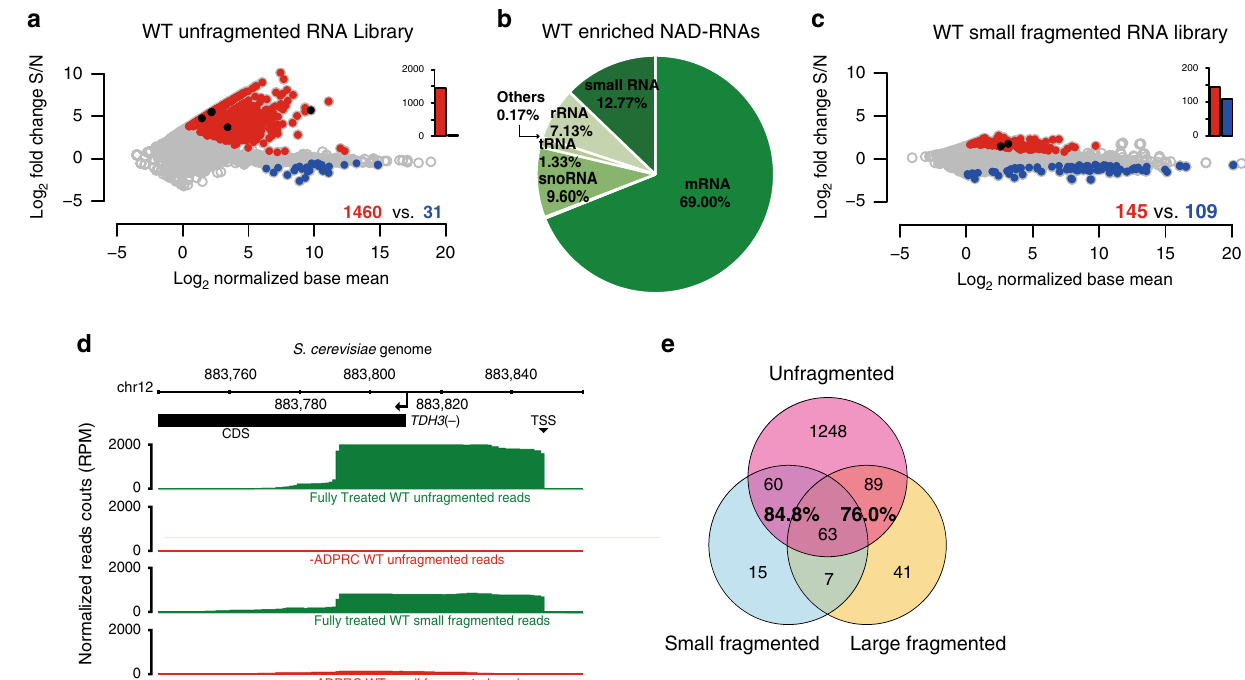
Fig. 1 NAD-RNAs are abundant in the yeast S. cerevisiae . a Enriched NAD-RNAs as determined by unfragmented NAD captureSeq on the wild-type (WT) strain. The log 2 fold change between fully treated sample (S) and minus ADPRC negative control (N) is plotted vs. the log 2 normalized base mean. Different transcripts (7620) were analyzed and are represented as a dot. Red dots represent enriched NAD transcripts (fold change (FC) > 1.414, normalized base mean (NBM) > 1, p < 0.05); blue dots represent negatively enriched transcripts (FC < 0.707, NBM > 1, p < 0.05); black dots denote transcripts previously reported as NAD-capped 8 . The bar chart represents the number of red and blue dots using the same color. Performed in biologically independent replicates, n = 3. b Reads of enriched NAD-RNA from the WT unfragmented NAD captureSeq library, mapped to genome-annotated RNAs. Chart contains reads classi fi ed as genome-annotated RNAs (reads ≥ 18 nt, same statistics parameters as in a ), plus the self-categorized small RNAs (12 nt ≤ reads < 18 nt, fold change S/N > 1.414). Other categories included the classes pseudogene (0.093%), ncRNA (0.057%), and long-terminal repeat RNA (0.017%). The pie chart represents the number of reads assigned to each RNA class as percentage of total reads. c Enriched NAD-RNAs as determined by small fragmented NAD captureSeq on WT strain. Random-sheared total RNA as input and sized selected cDNA (insert < 172 bp) was utilized for library building. Statistics parameters are as in a . Performed in biologically independent replicates, n = 3. d Aligned sequencing reads of the TDH3 gene are visualized in the integrated genome browser (IGB). The read count was normalized as reads per million genome-mapped reads (RPM). The arrow indicates the transcription direction and the coding sequence is displayed as black bar. The chromosome number and genome locus are denoted at the top. “ Fully treated ” represents the library with ADPRC treatment, whereas − ADPRC stands for the library obtained by omitting this treatment. e Venn diagram displaying the intersection of enriched NAD-RNA species among the unfragmented, small fragmented, and large fragmented WT NAD captureSeq libraries. The percent values are de fi ned as number of shared species, divided by the total number of species in the fragmented library. Source data are provided as a Source Data fi